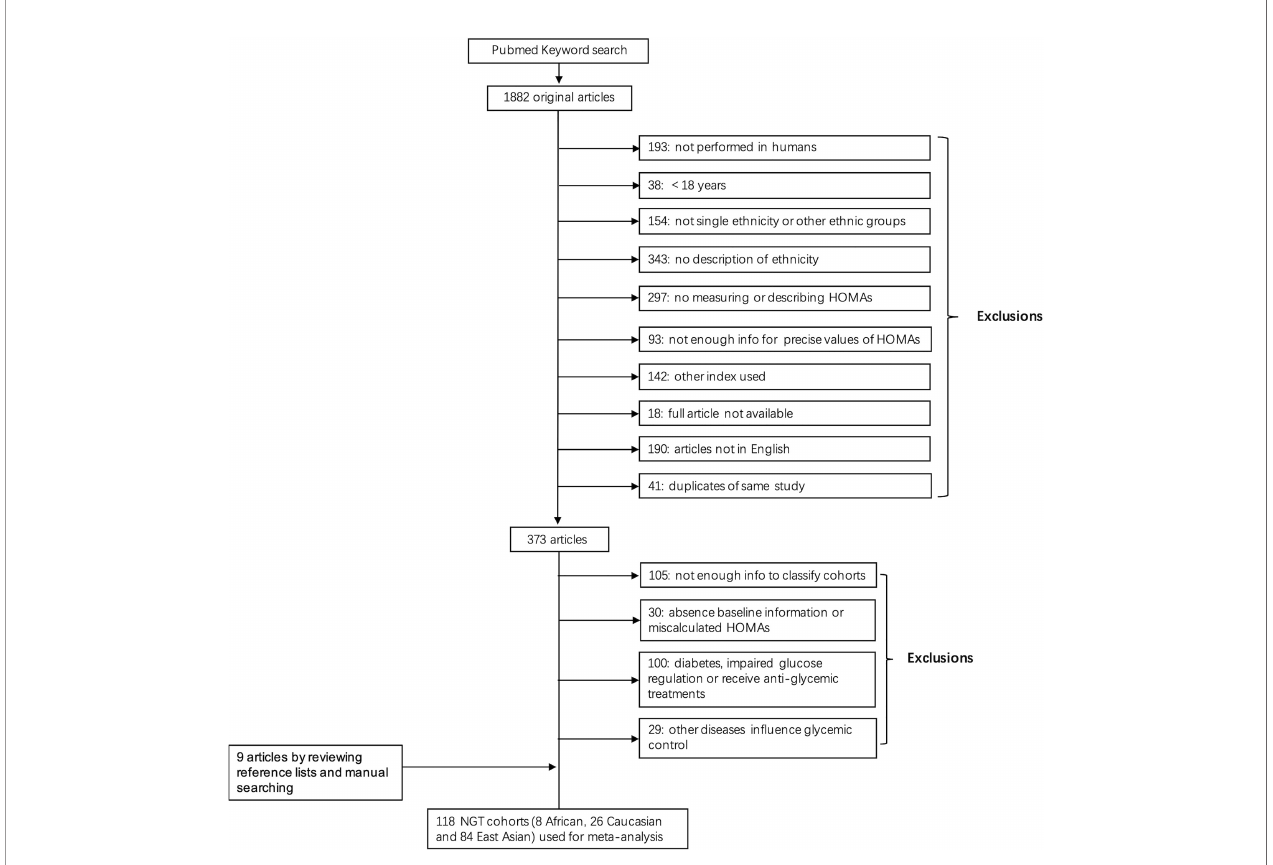
FIGURE 1 | Flow diagram of literature search and cohort identi fi